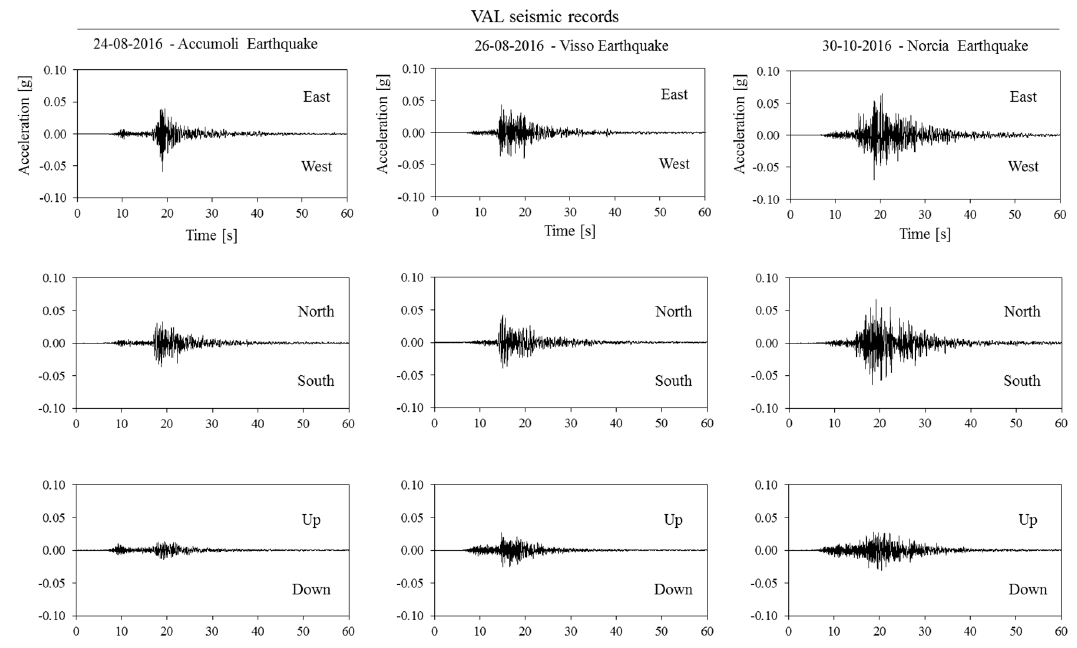
Figure 4. East–west, north–south, and up–down seismic signals recorded at the “Valfabbrica” seismic station (VAL) during the three strong motion events of the 2016 Central Italy seismic sequence.